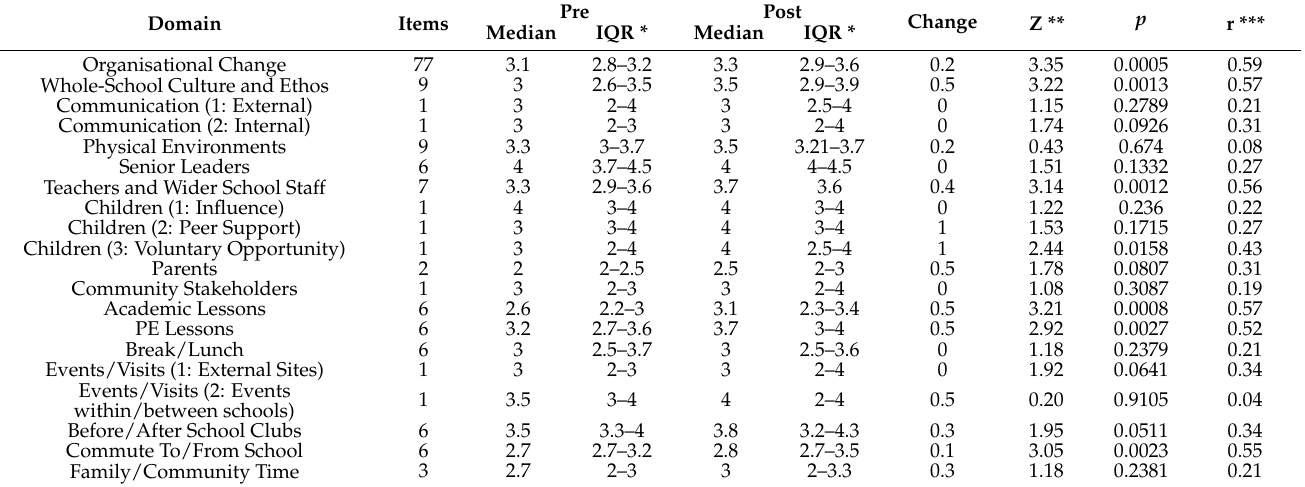
Table 2. Descriptive statistics and results from the Wilcoxon Signed Rank test for changes in organi- sational physical activity provision.